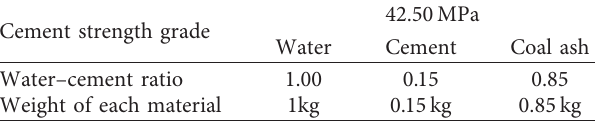
Table 1: Cement strength grade and water–cement ratio. Cement strength grade